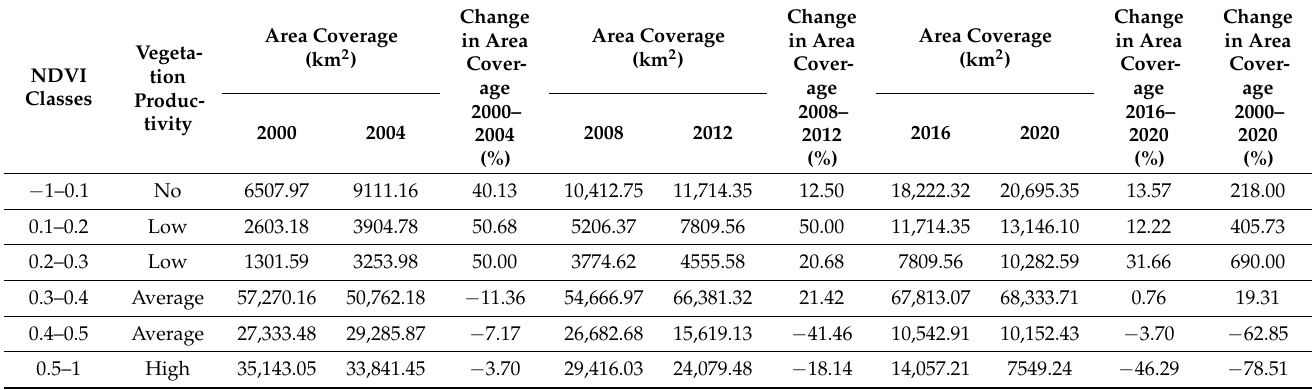
Table 6. Change in the areal distribution of the NDVI classes for Tamil Nadu for two